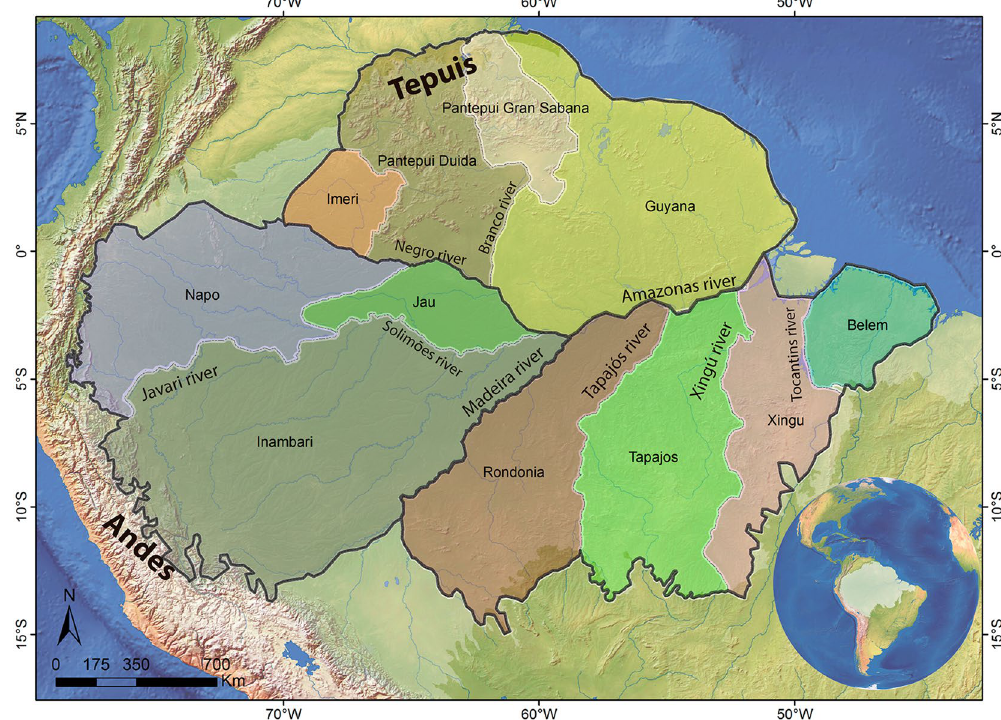
Figure 1. Interfluve hypothesis of Amazonian areas of endemism. The currently accepted Areas of Endemism classification of the Amazon, depicted here, was proposed by Cracraft (1985) and subsequently modified by Silva et al . (2002), Naka (2011) and Borges & Silva (2012). Dark lines indicate limits of Wallace (1852) districts. Map created in ArcGIS 10 . 1